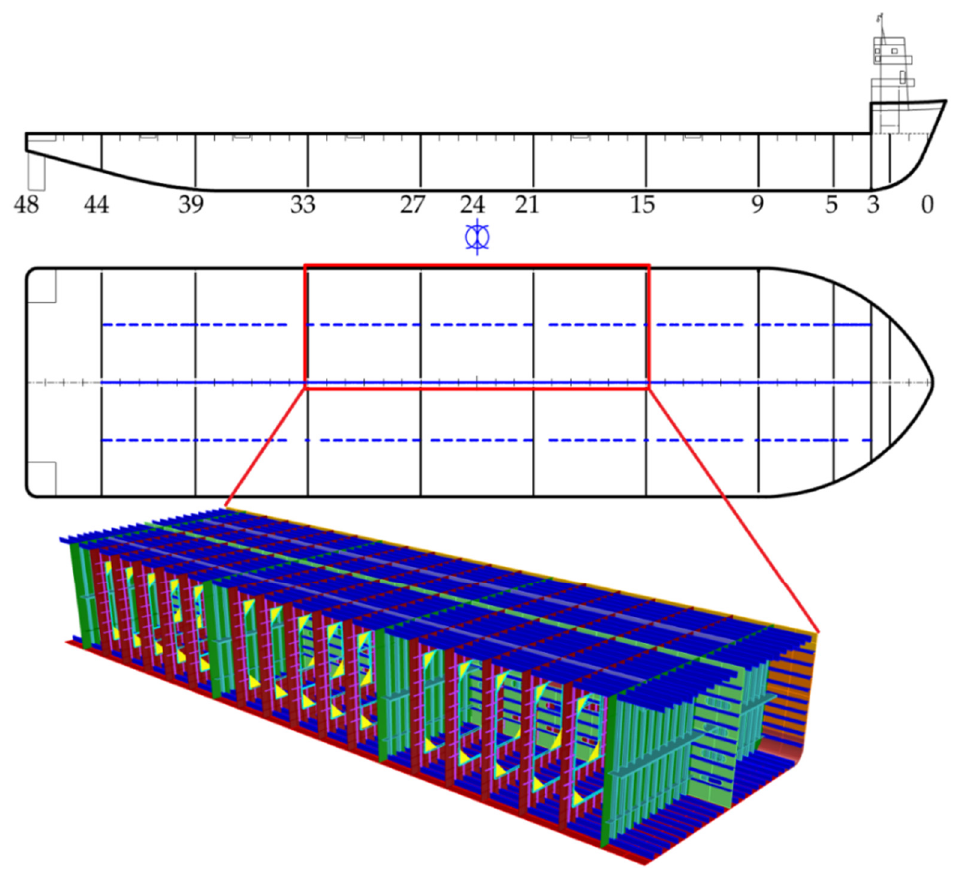
Figure 1. 3D view of the structural components of the barge midship section.